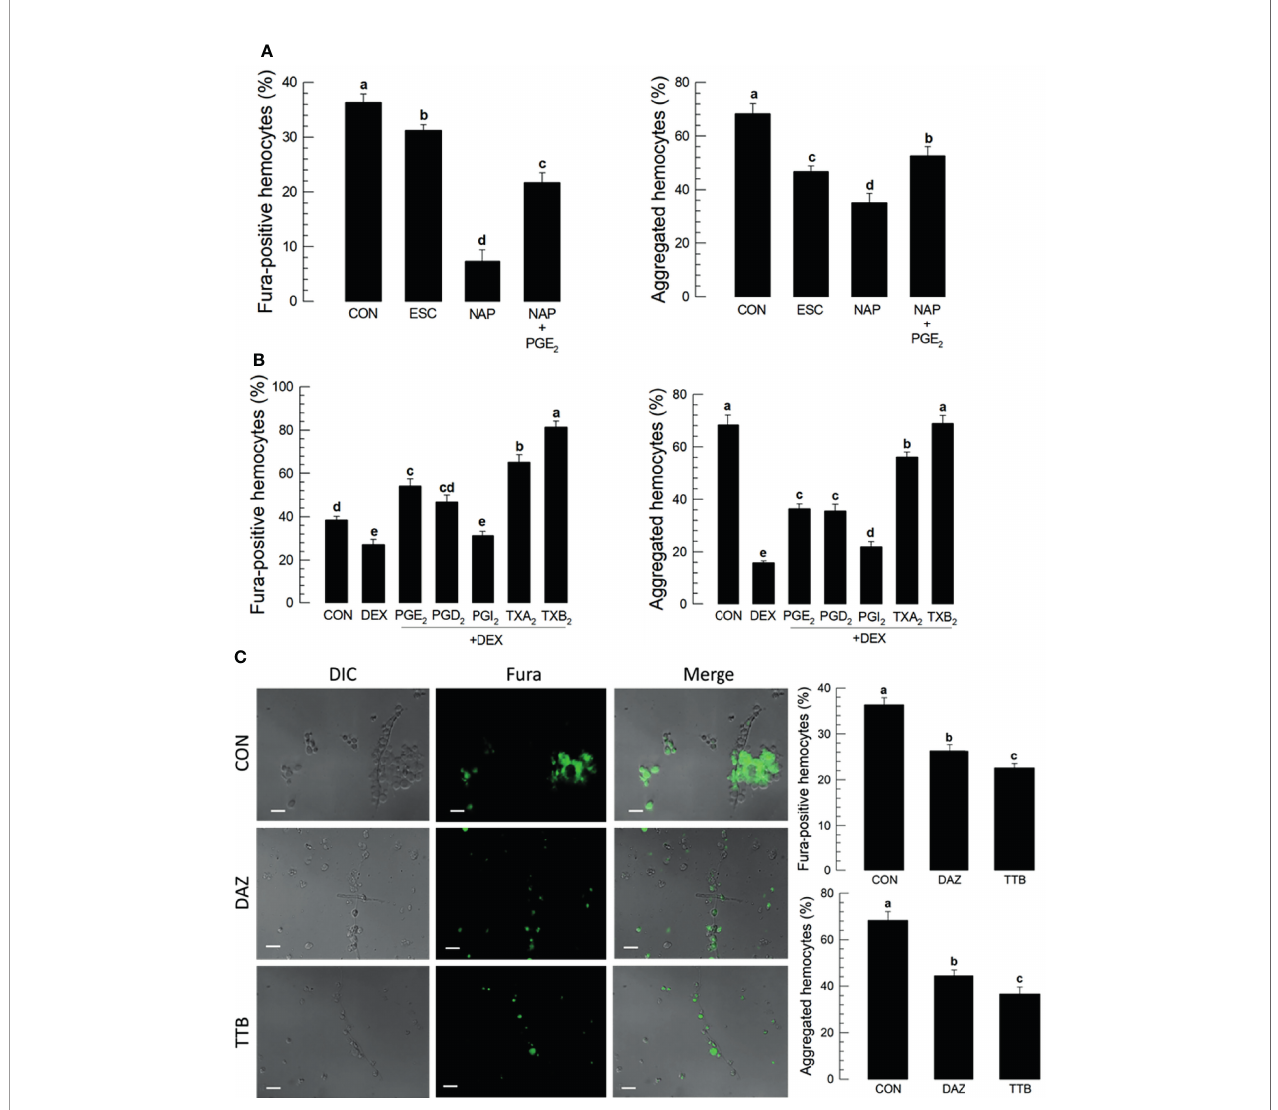
FIGURE 3 | Thromboxanes (TXA 2 and TXB 2 ) induce Ca 2+ signaling and hemocyte aggregation in S. exigua . Panel (A) reports that the COX inhibitor, NAP, but not LOX inhibitor, ESC, led to reduced proportions of Fura-positive hemocytes and reduced proportions of aggregated hemocytes. Co-injections with NAP+PGE 2 (1 µg/ µL) rescued the in fl uence of inhibiting COX. Panel (B) displays the in fl uence of DEX on Ca 2+ signaling and hemocyte aggregation, which were reversed in larvae treated with DEX+the indicated prostanoids. Panel (C) shows the in fl uence of the thromboxane biosynthesis inhibitor DAZ and the thromboxane receptor antagonist, TTB, on Ca 2+ signaling and hemocyte aggregation. The micrographs convey visual images, with reduced Fura signaling and the accompanying histograms show quantitative data with statistical analysis. Each treatment was replicated three times. Data analyzed and presented as described in Methods . Different letters above standard deviation bars indicate signi fi cant difference among means at Type I error = 0.05 (LSD